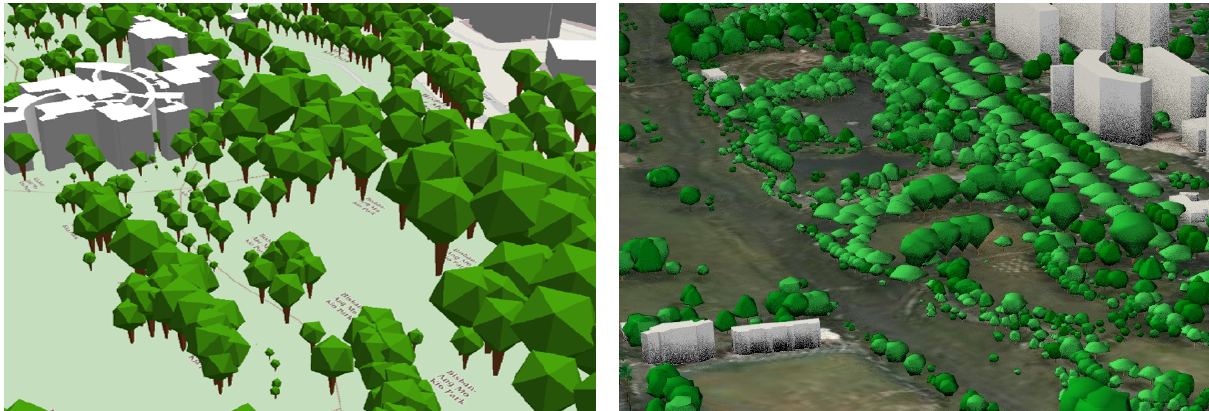
Figure 12. LOD1 models on a Singapore test site Figure 13. LOD2 models on a Singapore test site